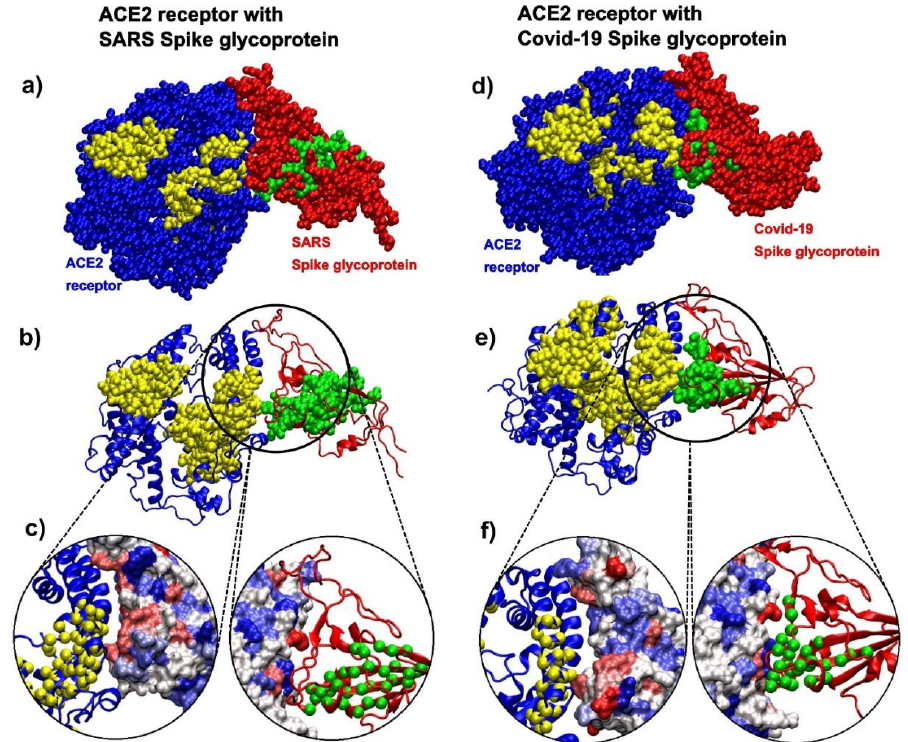
Figure 8. SARS spike glycoprotein chain B RBD bound to the angiotensin-converting enzyme 2 (ACE2) receptor (pdb id 6cs2) in comparison to COVID-19 spike glycoprotein chain A RBD bound to the ACE2 receptor (pdb id 6m0j). ( a ) The ACE2 receptor is represented via blue atoms and its SAGM predictions are yellow atoms. SARS spike glycoprotein is represented via red atoms, and its SAGNM predictions and green atoms. ( b ) The ACE2 receptor is represented as a blue ribbon, and its SAGM predictions are yellow atoms. SARS spike glycoprotein is the red ribbon, and its SAGNM predictions and green atoms. ( c ) Contact areas for both chains are represented as hydrophobicity surfaces. The contact chains in each case are shown as ribbons, and predictions are represented via C α atoms only. ( d ) The ACE2 receptor is represented via blue atoms, and its SAGM predictions are yellow atoms. COVID-19 spike glycoprotein is represented via red atoms, and its SAGNM predictions and green atoms. ( e ) The ACE2 receptor is represented as a blue ribbon, and its SAGM predictions are yellow atoms. COVID-19 spike glycoprotein is the red ribbon, and its SAGNM predictions are green atoms. ( f ) Contact areas for both chains are represented as hydrophobic surfaces. The contact chains in each case are shown as ribbons, and predictions are represented via C α atoms